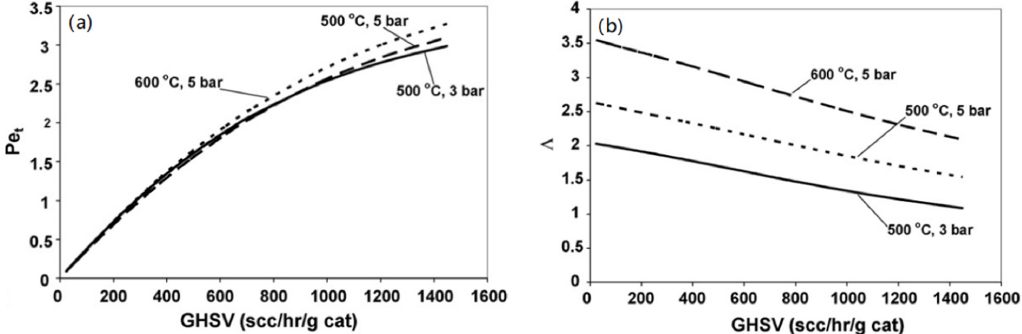
Figure 15. Dependence of Pe t number ( a ) and Λ number ( b ) on GHSV under different working conditions [58]. GHSV denotes the gas hourly space velocity; cat denotes the cat- alyst.